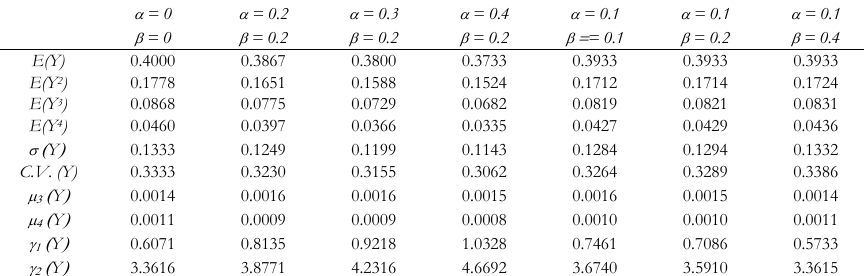
Effects of the parameter values on moments, variability, skewness and